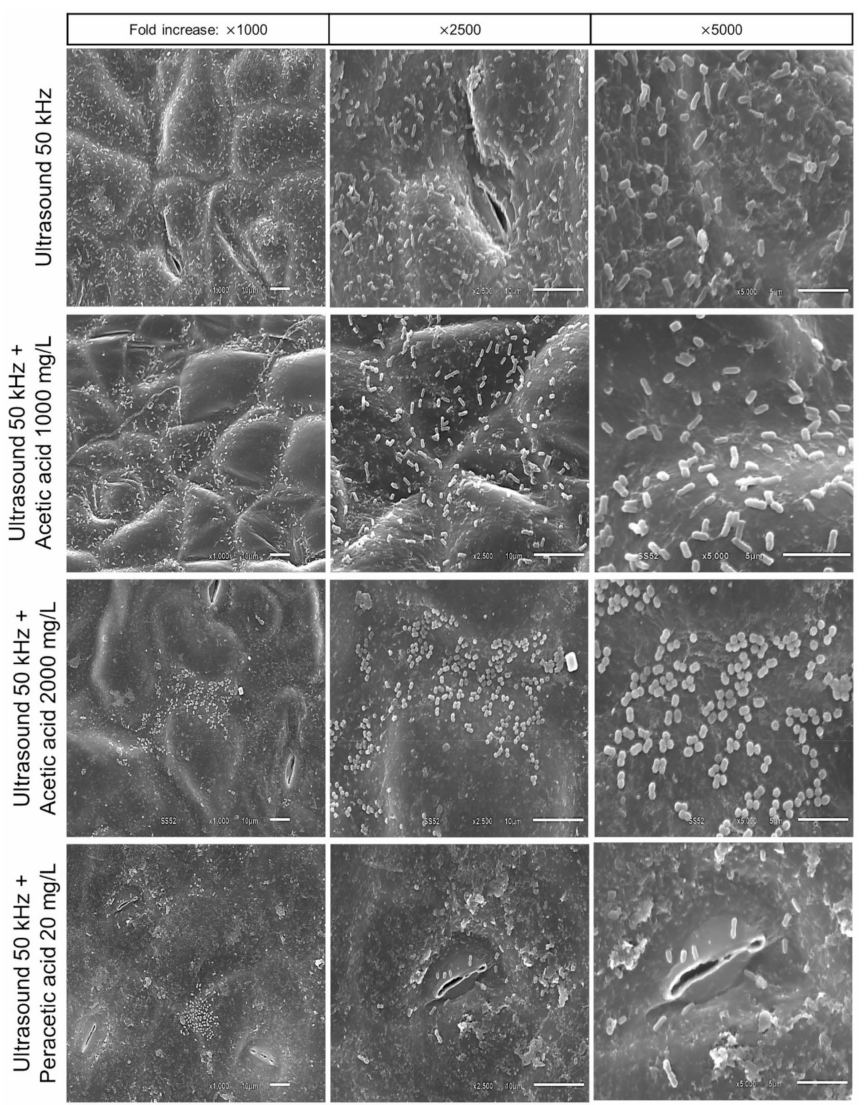
Figure 4. Scanning electronic microscopy micrographs of kale samples intentionally contaminated with S. Typhimurium cells ATCC 14028 and submitted to different sanitization treatments (Ultrasound 50 kHz, Ultrasound 50 kHz + Acetic Acid 1000 mg/L; Ultrasound 50 kHz + Acetic Acid 2000 mg/L; Ultrasound 50 kHz+ Peracetic Acid 20 mg/L) for 5